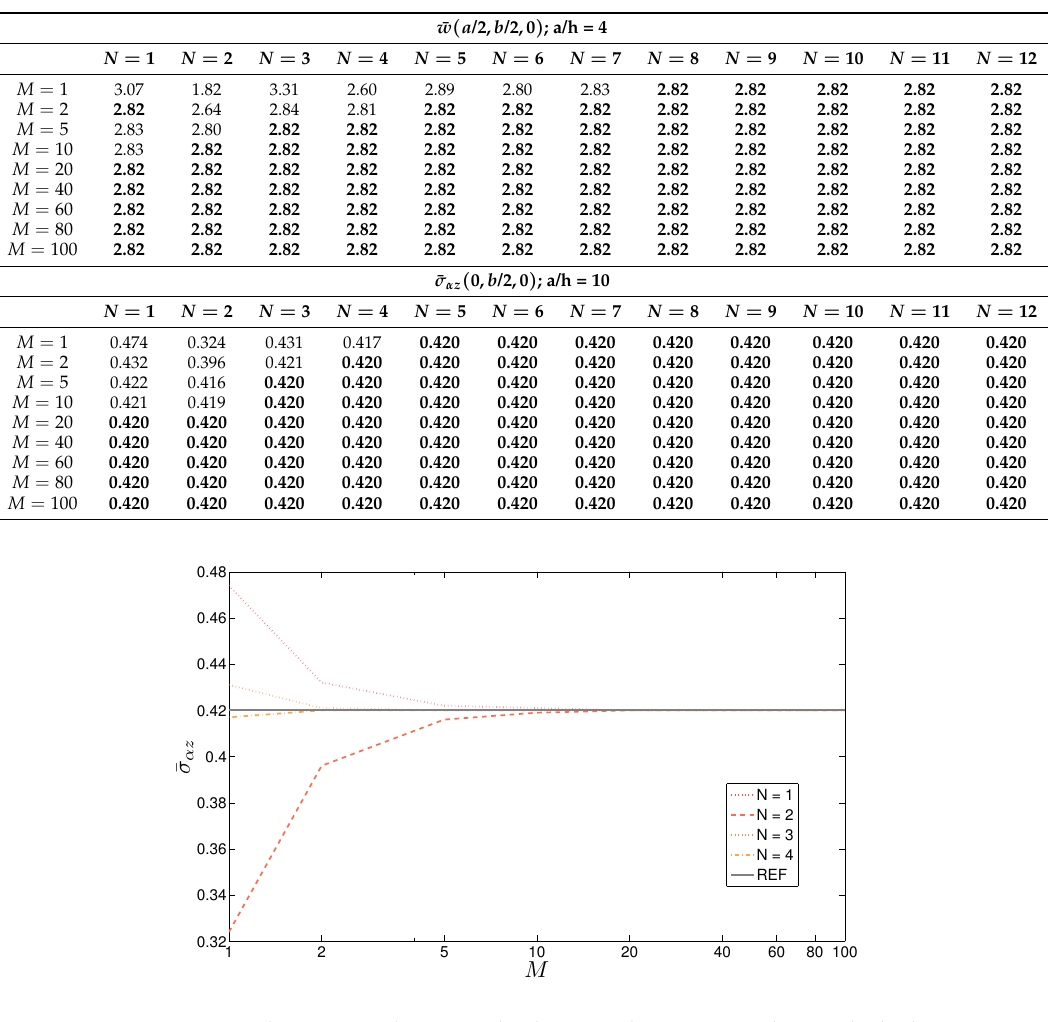
Table 3. Case 1. Rectangular laminated composite plate. Displacement ¯ w for thickness ratio a / h = 4 and stress ¯ σ α z for thickness ratio a / h = 10, both evaluated in the middle and given as dimensionless values. Each physical layer ( N L = 3) is divided into M mathematical layers. 3D reference solution by Pagano [6].